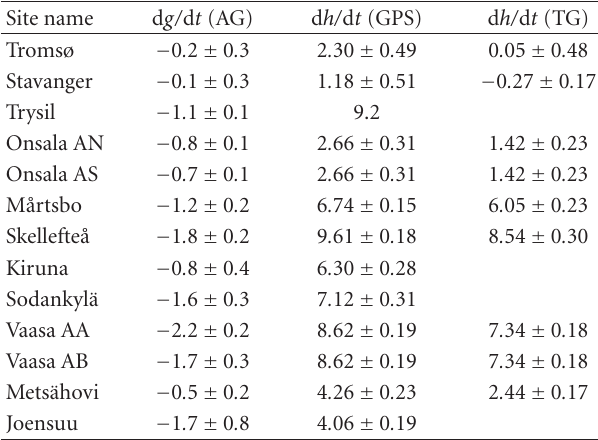
Table 1: Rates of gravity change ( µ Gal/yr) and geometric height change (mm/yr) in Fennoscandia.